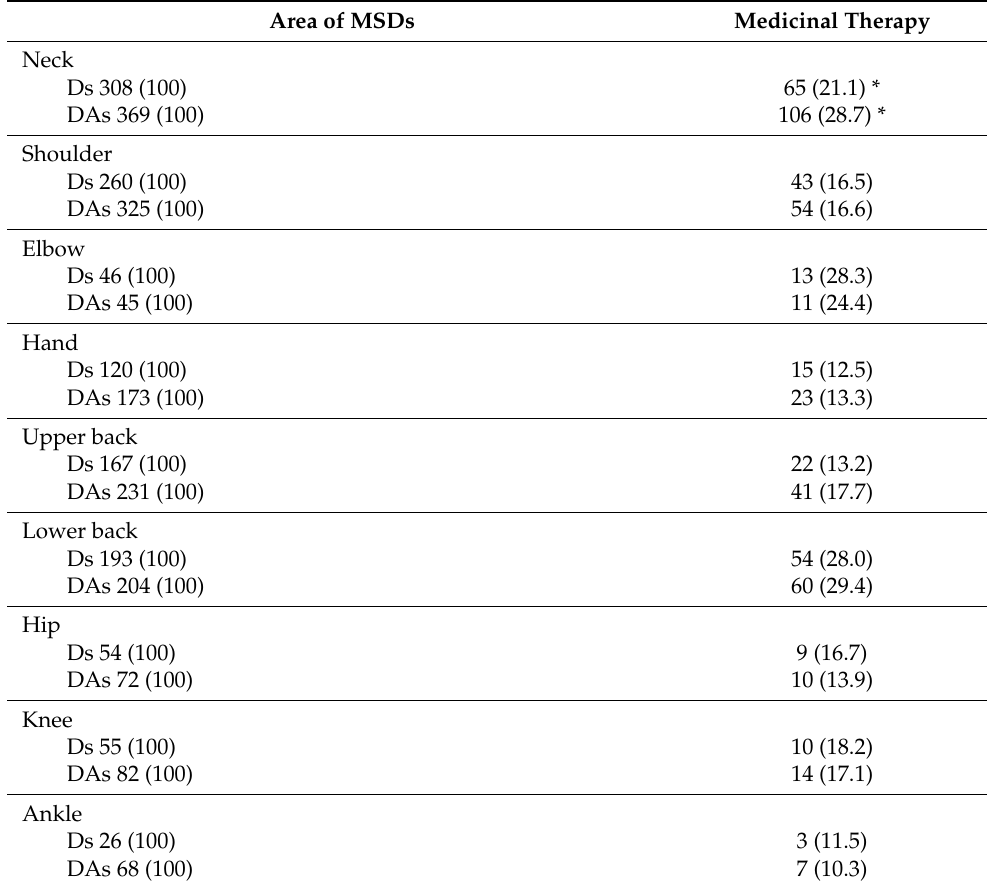
Table 2. Medical therapy of MSDs among Ds and DAs in Germany in n (%). Area of MSDs Medicinal